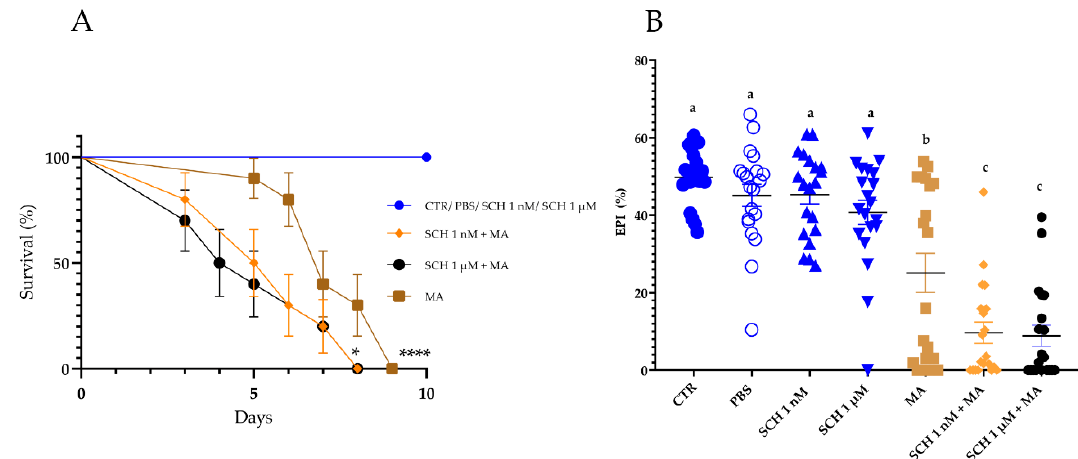
Figure 2. ( A ) Effect of dopamine receptor antagonist SCH23390 on the survival of Rhipicephalus mi- croplus females associated or not with Metarhizium anisopliae . Mean survival (%) and standard devi- ation of females inoculated with M. anisopliae conidia according to Log-rank ( p < 0.0001). A repre- sentative experiment of three independent replications, where (*) represents statistical difference between survival averages from MA and SCH 1 nM + MA ( p = 0.0253) or MA and SCH 1 µM + MA ( p = 0.0291), and (****) represents statistical difference between survival averages from MA and CTR ( p < 0.0001) or MA and SCH 1 nM or SCH 1 µM ( p < 0.0001). ( B ) Egg production index (EPI) of R. microplus females inoculated with antagonist SCH 23390 at 1 nM or 1 µM, M. anisopliae LCM S04 at 1.0 × 10 7 conidia/mL and associations. Different letters differ statistically. CTR: untreated ticks; PBS: ticks inoculated with phosphate buffer solution; SCH 1 nM: ticks inoculated with antagonist at 1 nM; SCH 1 µM: ticks inoculated with antagonist at 1 µM; MA: ticks inoculated with M. anisopliae ; SCH 1 nM + MA: ticks inoculated with the lowest concentration of antagonist and fungus; SCH 1 µM + MA: ticks inoculated with the highest concentration of antagonist and fungus.